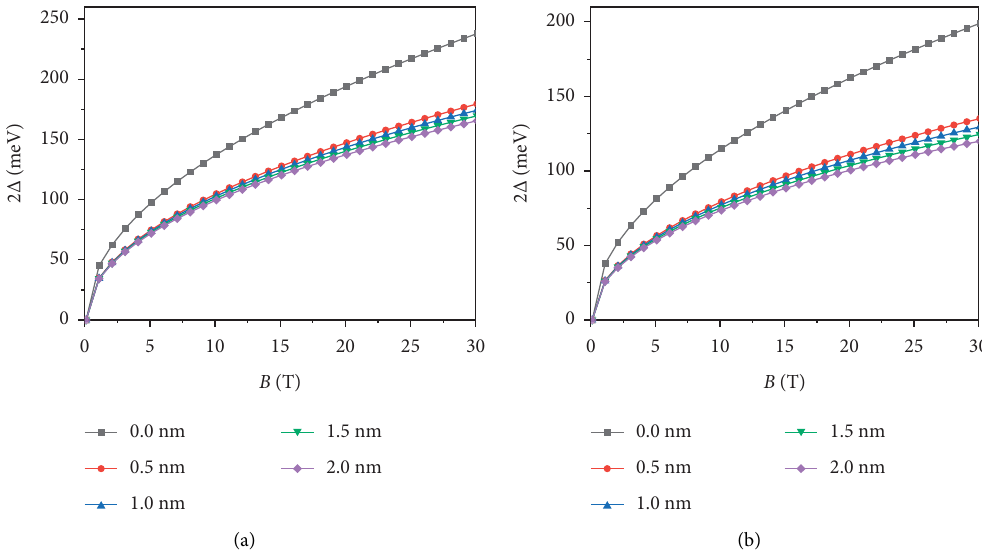
Figure 4: Relations between splitting energy 2 Δ and magnetic field B with different z